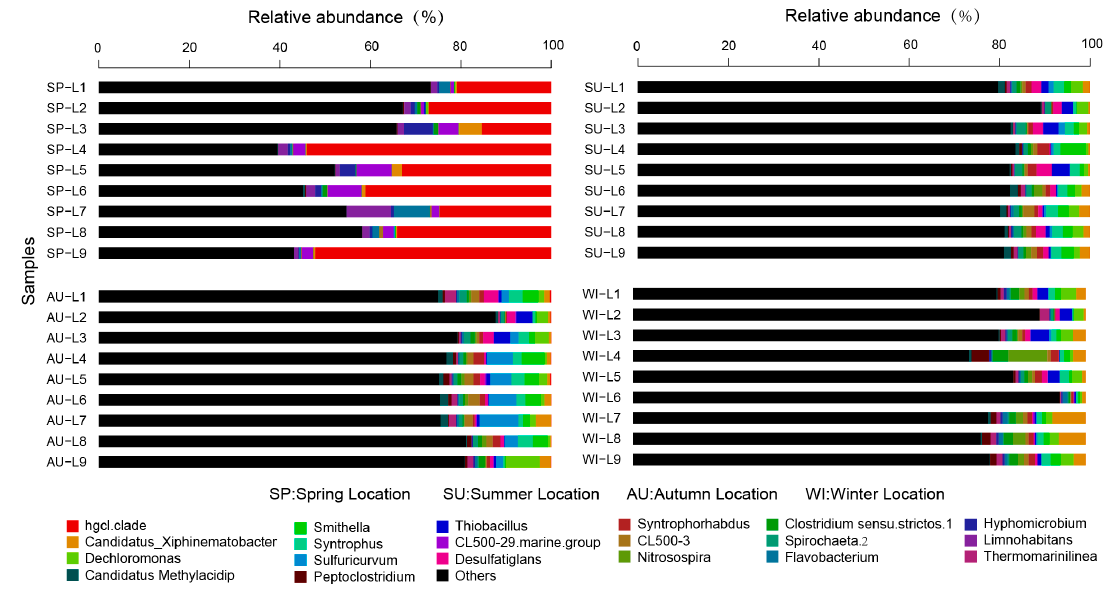
Figure 5. Relative abundance and composition of bacterial genera detected in sediments of Sancha Lake in four seasons.